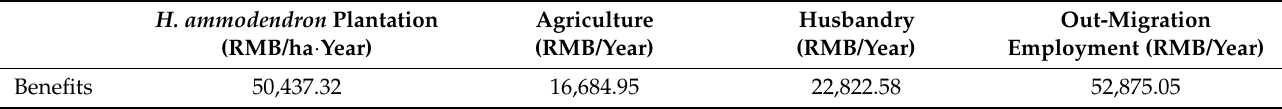
Table 4. Benefits of each